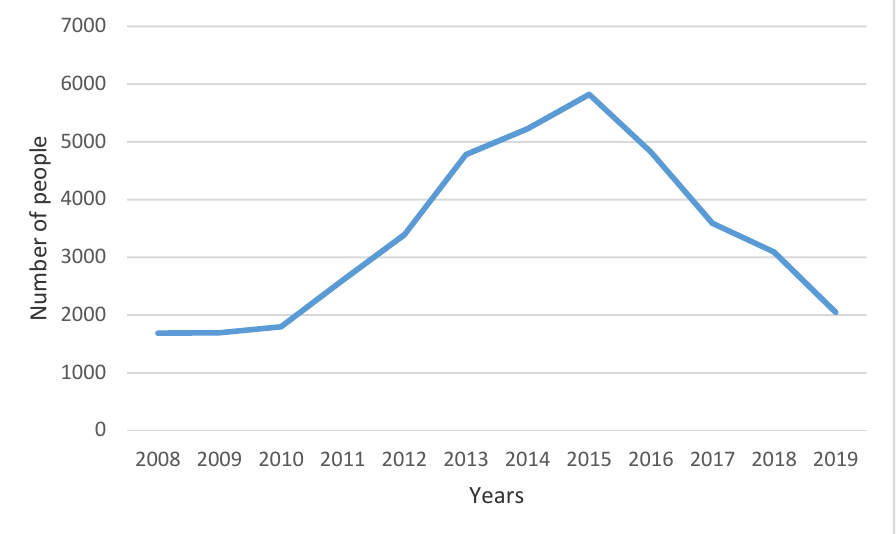
Figure 2. Emigration of Spaniards aged 25 to 34 to Latin America. Source: compiled by the authors based on data from the Spanish National Statistics Institute (Instituto Nacional de Estadística 2019).